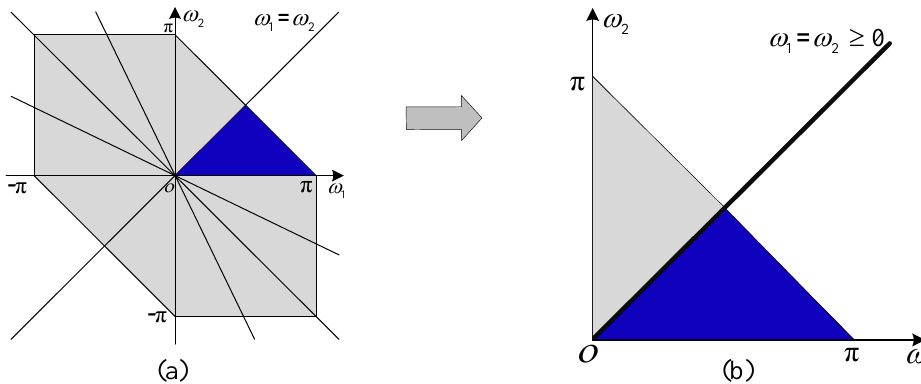
Figure 2. Symmetrical areas of bispectrum. ( a ) Twelve symmetric areas of the bispectrum. ( b ) One of the effective areas of the bispectrum.